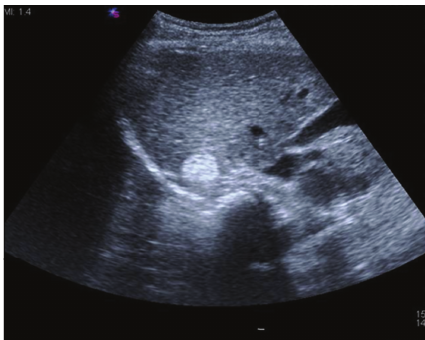
Figure 1: Ultrasonographic findings of the liver mass. Ultrasonogram demonstrates a 2.5cm sized round, well-marginating hyperechoic mass.